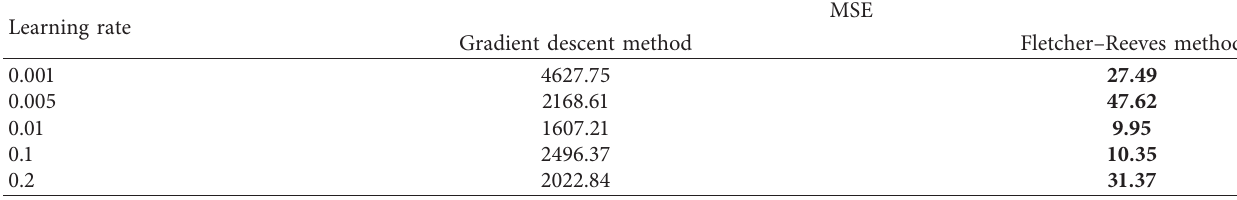
Table 7: Evaluation of the performance of the prediction method for the number of COVID-19 sufferers by using testing data for several learning rates with 50 hidden neurons.